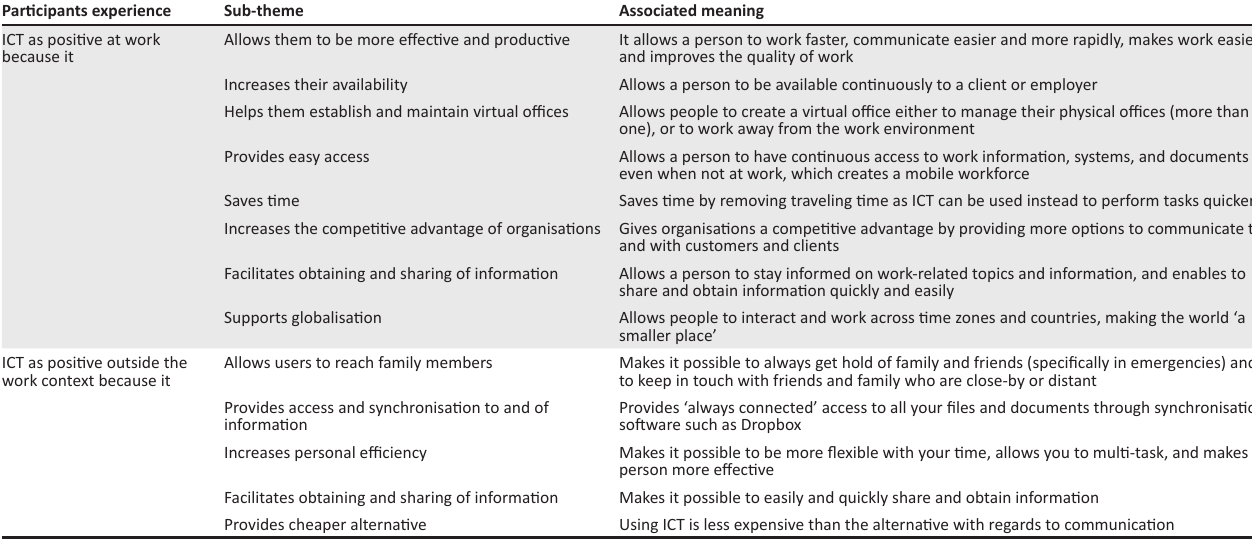
TABLE 1: Theme 1: Positive experiences of ICT. Participants